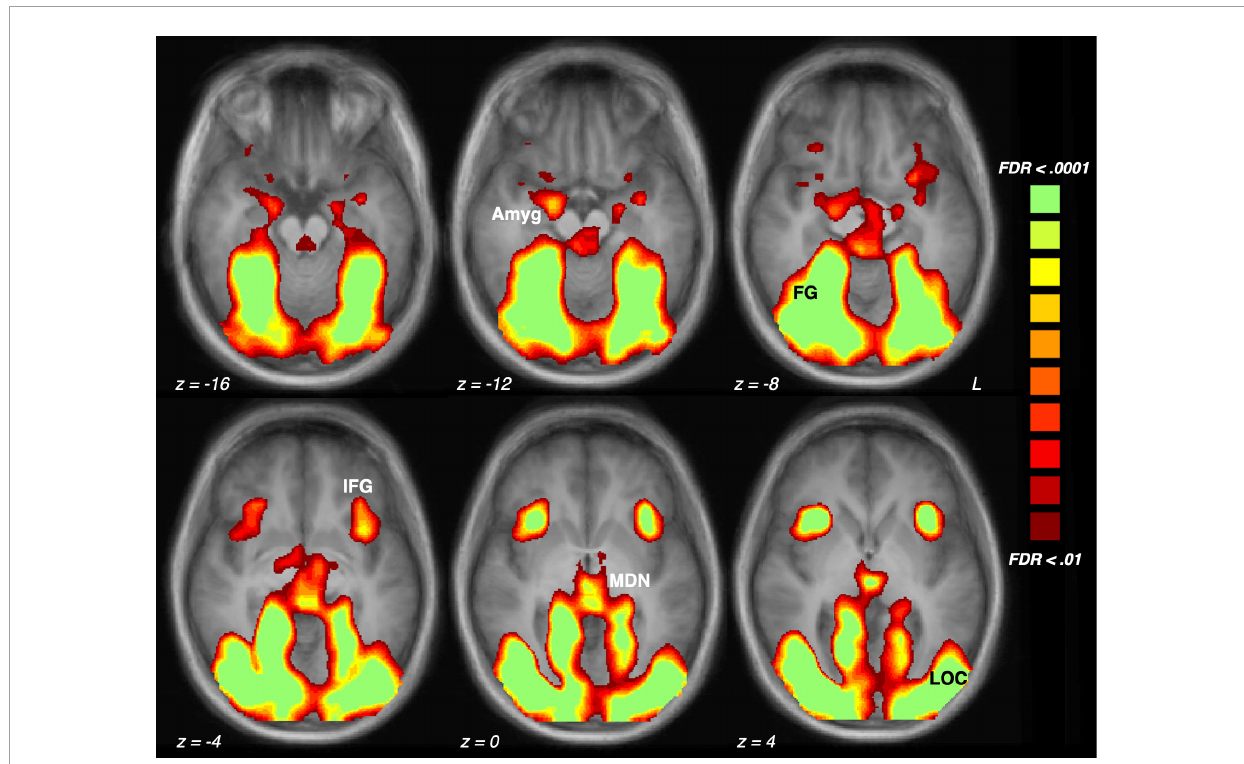
FIGURE1 Brain activation driven by emotional (pleasant and unpleasant) compared to neutral scene perception across the sample of 23 participants. The five regions of interest are indicated: Amyg, amygdala; FG, fusiform gyrus; IFG, inferior frontal gyrus/anterior insula; MDN, medial dorsal nucleus of the thalamus; LOC, lateral occipital